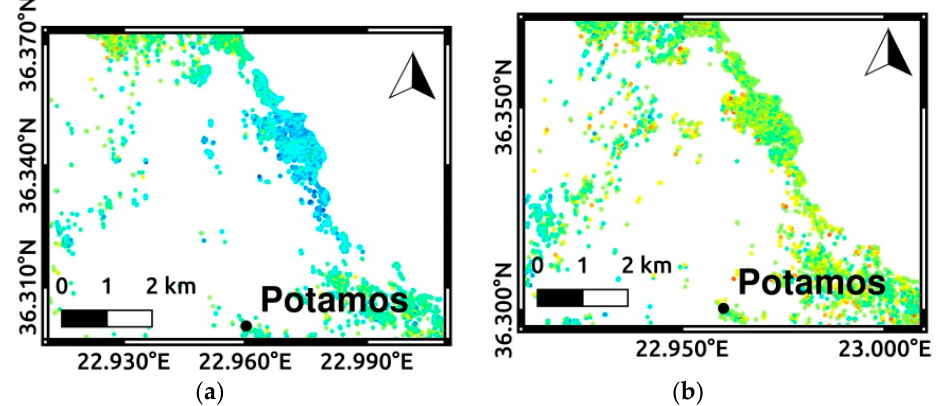
Figure 7. A closer view of PS scatterers near the Potamos village, where opposite LOS displacements are identified. ( a ) Sentinel-1 LOS displacements, ascending track no. 102; ( b ) Sentinel-1 LOS displacements, descending track no. 7.